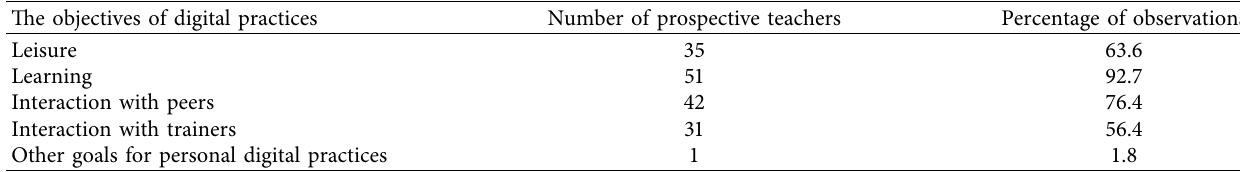
Table 6: The objectives of the digital practices of prospective teachers.